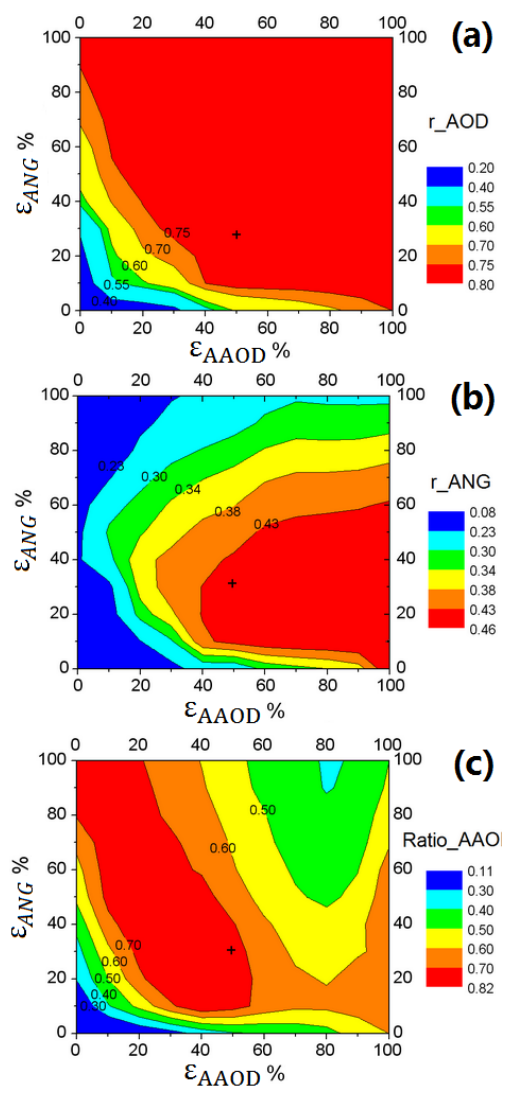
Figure 4. Sensitivity analysis for correlations between adjusted MISR (a) AOD, (b) ANG, (c) AAOD and AERONET by thresh- olds of ANG and AAOD. The axes specify the percent of mixtures passing the MISR retrieval acceptance criteria coming closest to the GOCART model value that is retained by our method (Eqs. 4 and 5), so a smaller number means the model is used to provide a tighter constraint. The resulting agreement is then assessed based on MISR–AERONET coincident observations. The color from blue to red represents the correlation coefficients (for AOD of Fig. 4.a and ANG of Fig. 4.b) or the mean ratio (for AAOD of Fig. 4.c) from low to high; so for each panel, colors toward “red” indicate bet- ter MISR–AERONET agreement when the GOCART–MISR agree- ment criteria specified by the axes are applied.